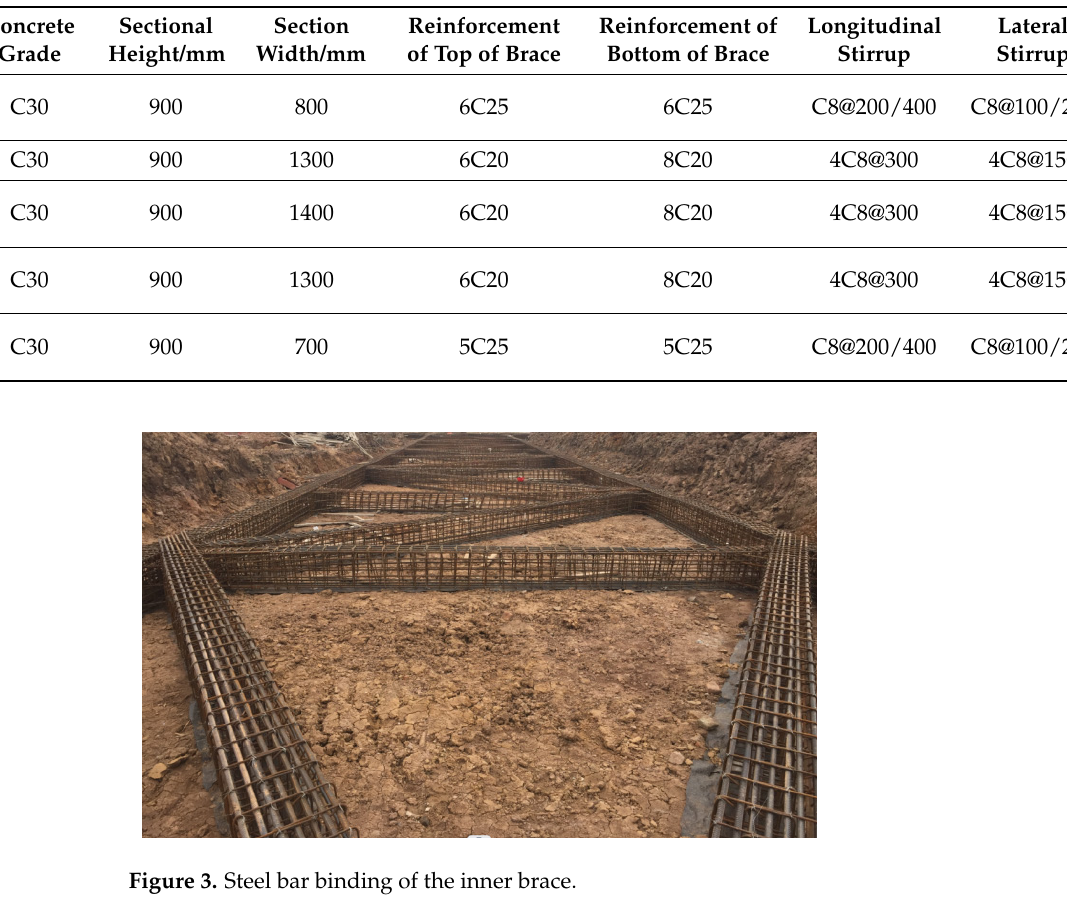
Table 2. Sectional parameters of the braces.